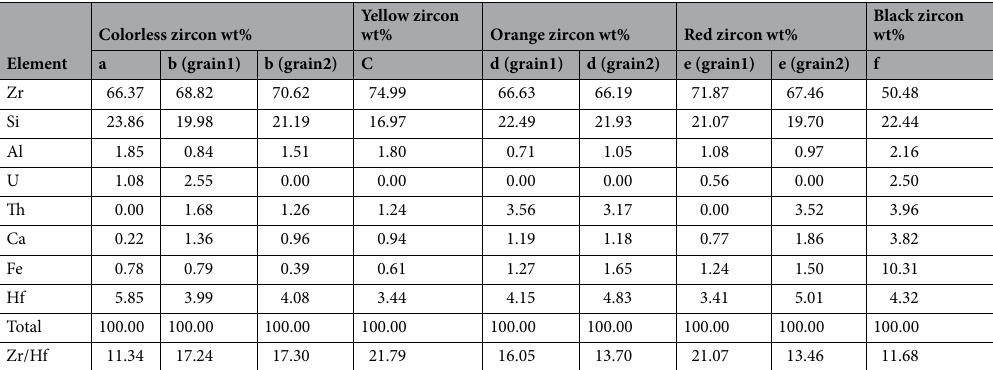
Table 5. EDX microanalysis data of zircon (carbon and oxygen are excluded).